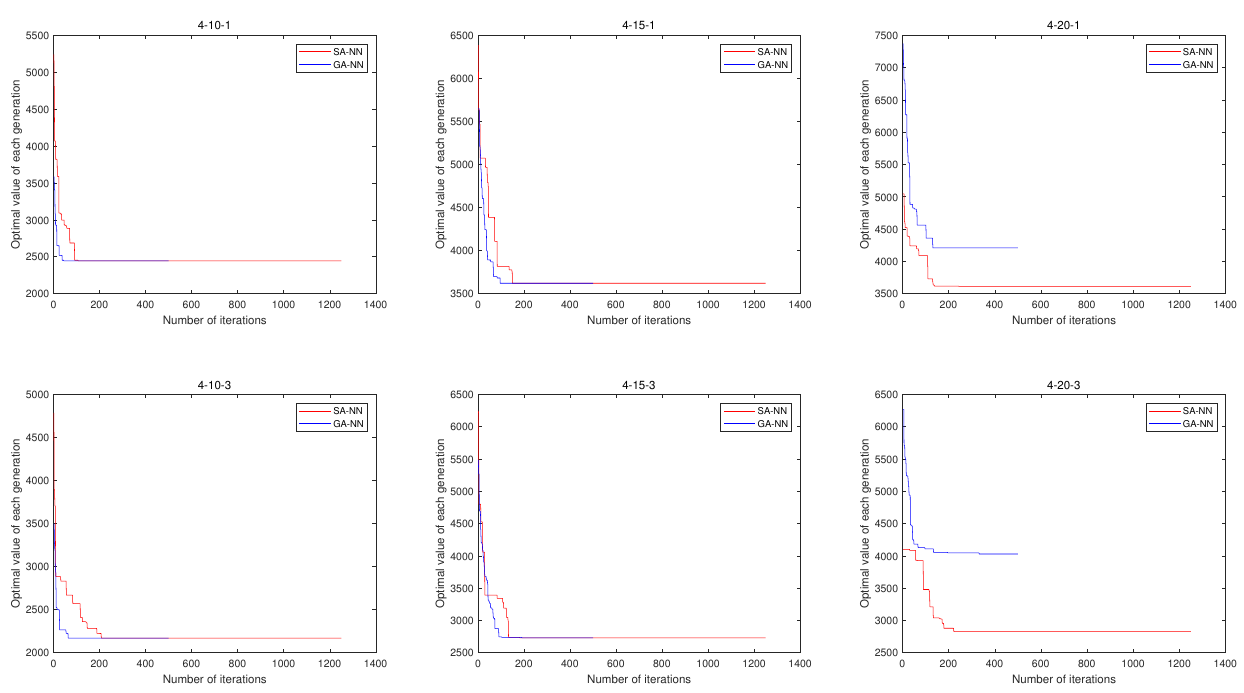
Figure 7. Objective value evolution curve for Instance